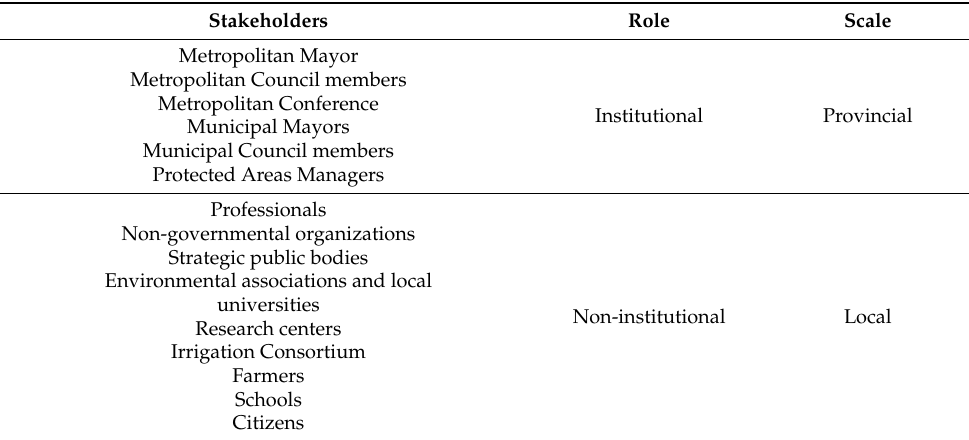
Table 8. Stakeholders to be involved in the drafting of the GI guidelines for the Metropolitan City of Cagliari by role and